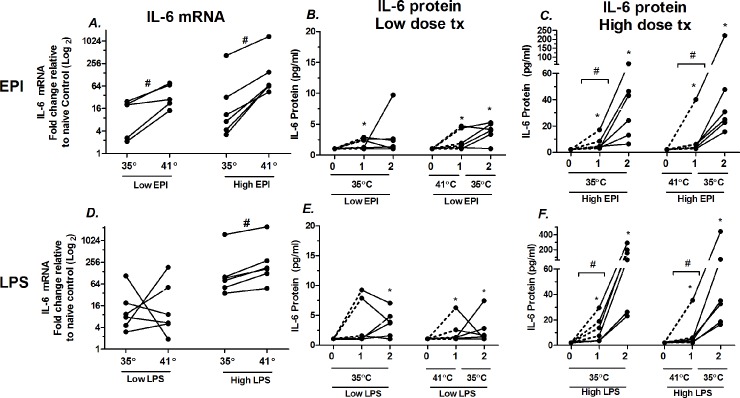
Effects of hyperthermia on low and high dose EPI- and LPS-stimulated IL-6 regulation in isolated soleus muscle.A) Effects of 1 h hyperthermia on IL-6 mRNA in low (1.2 ng/ml) and high dose (1 μg/ml) epinephrine (EPI). Each soleus measurement paired by animal, from one leg at 35°C; from the other leg treated for 1 h at 41°and then 1 h at 35°C. B. IL-6 protein secreted into the bath with exposure to low EPI, samples pulled and measured at 1 and 2 h after EPI and compared to fresh buffer (time 0). C) Identical to ‘B’ except high dose EPI. Bars represent paired comparisons. D) IL-6 mRNA response to low and high doses of LPS. E) IL-6 protein secretion in response to low dose LPS. F) IL-6 secretion in response to high dose LPS. n = 6 for all groups, except low dose mRNA to EPI (n = 5). # = P < 0.05 for paired measurements Wilcoxon signed ranks for paired samples. * = P < 0.05 for unpaired samples, Wilcoxon signed ranks for significance from lower limit threshold of IL-6 detection.